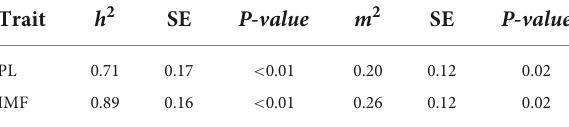
TABLE 3 Heritability and microbiability of PL and IMF in the resource